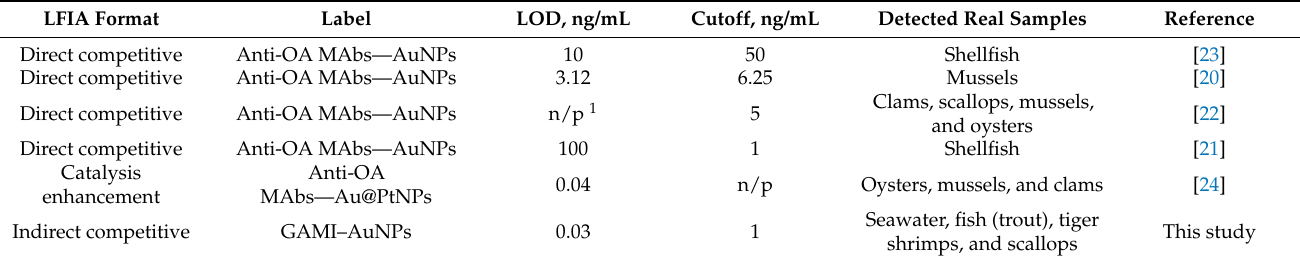
Table 2. Comparison of the developed LFIA with previous studies in this